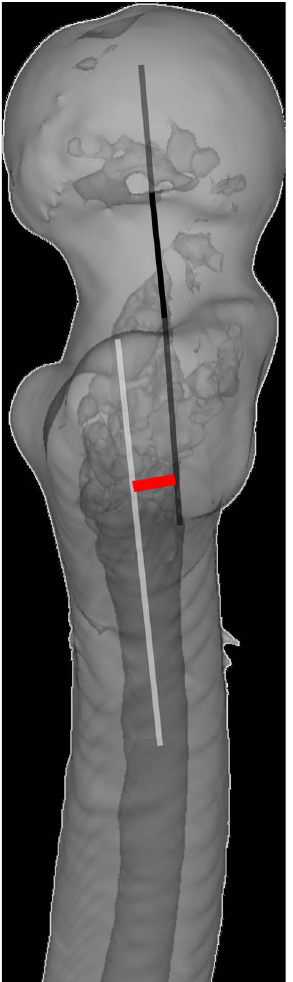
Figure 1. This image shows a lateral view of the proximal femur and illustrate an example of the femur neck-shaft axis offset. Black Line from the femur head: Illustrates the femur neck axis; White line extending into the femur medullary canal: Illustrates the proximal femur axis; Red short line: Illustrate the femur neck-shaft axis offset.